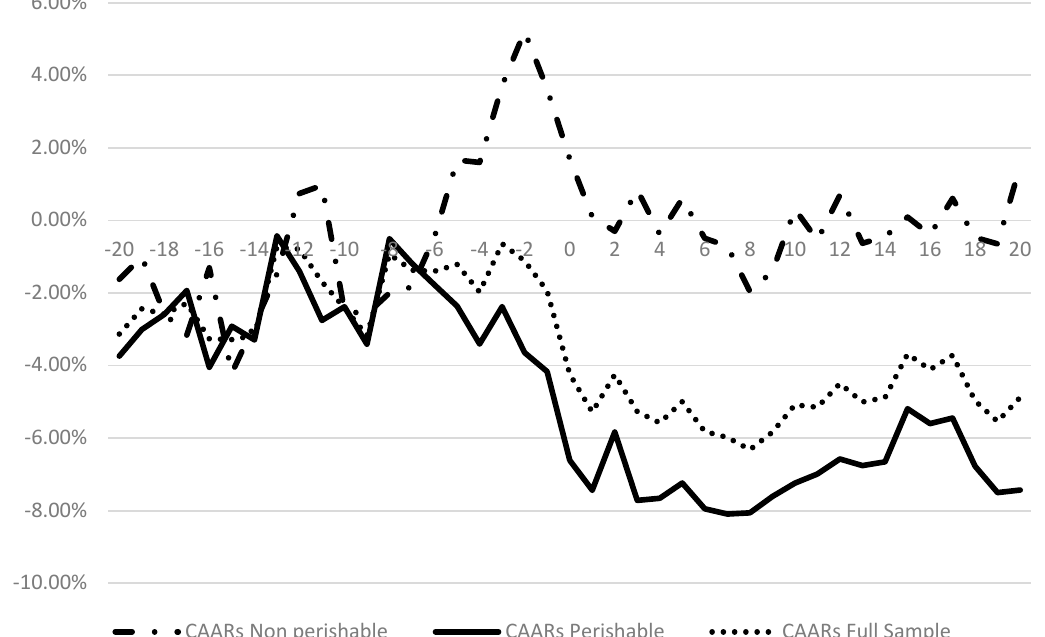
Water 2018 , 9 , x FOR PEER REVIEW